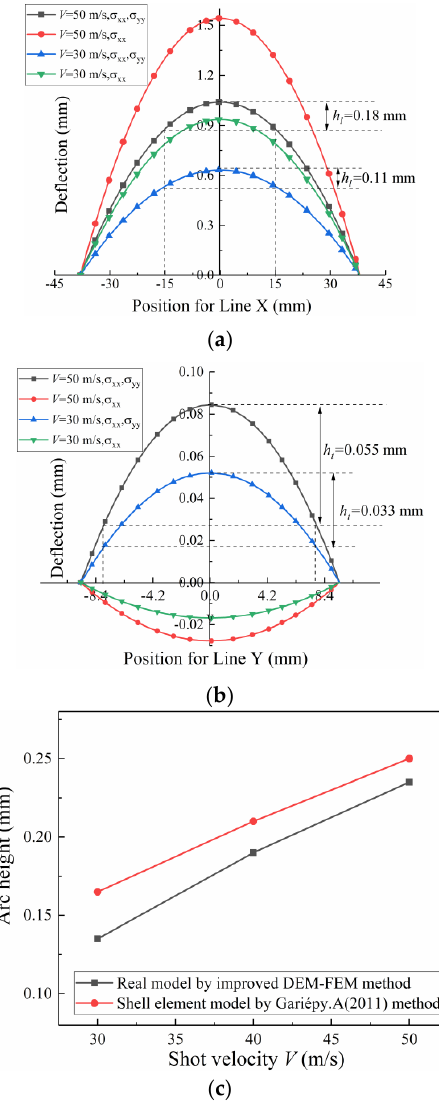
Figure 22. Current method. ( a ) Along the length profile and ( b ) across the width profile. ( c ) Comparison of arc height for the improved DEM-FEM method and existing shell element method.